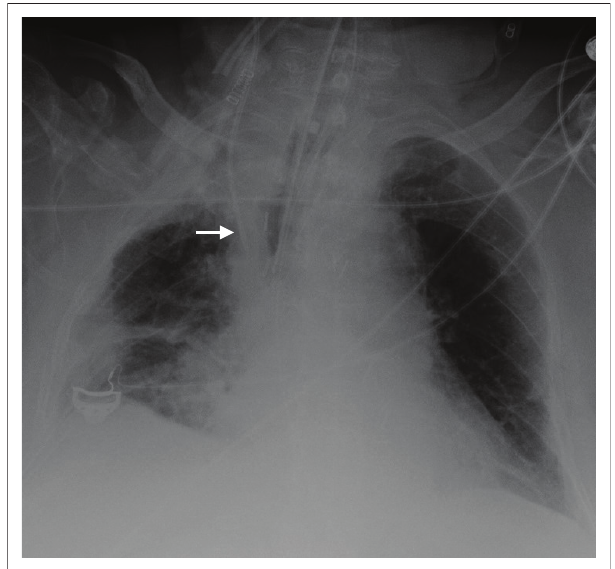
FIGURE 7: Magnified chest radiograph showing a widened superior mediastinum secondary to central venous catheter induced haematoma.